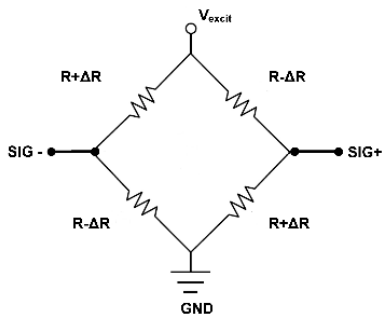
Figure 5. Four piezoresistive elements connected together in a Wheatstone bridge configuration.